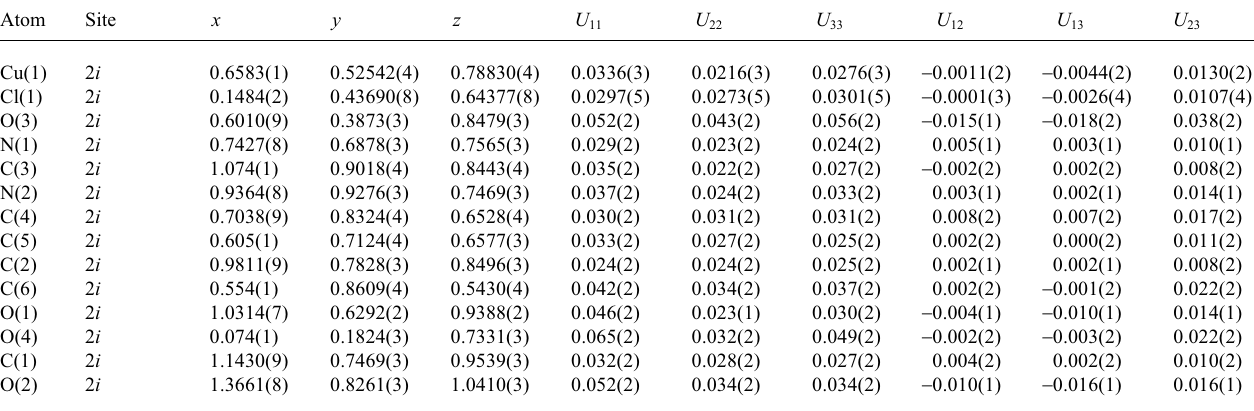
Table 3. Atomic coordinates and displacement parameters (in Å 2